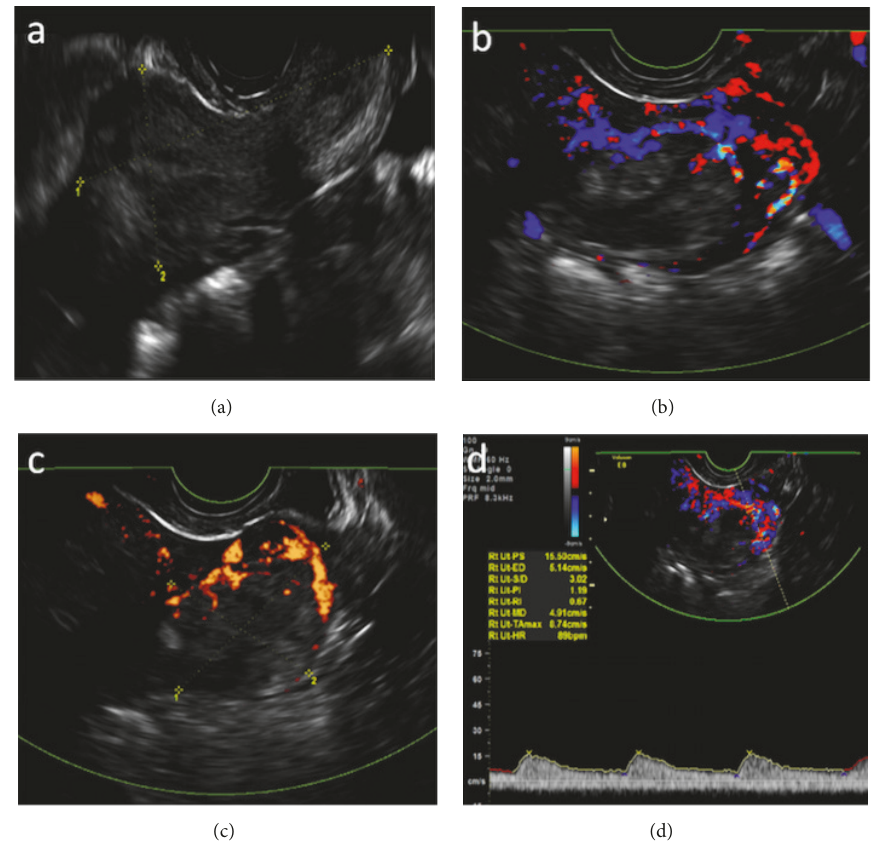
Figure 1: (a) Transvaginal sonographic sagittal section of the uterus revealing no signs of intrauterine pregnancy. (b) Color Doppler and (c) power Doppler transvaginal sonographic transverse sections of the left paraovarian tumor with strong peripheral vascularization. (d) Pulsed Doppler analysis of tumor vascularization, showing a pattern of low